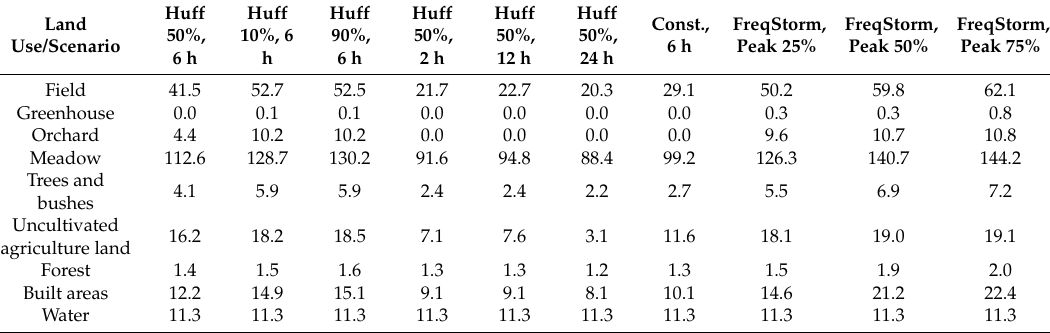
Table 8. Area (10 3 m 2 ) of flooded land use types for the 10 selected scenarios for the 100-year return